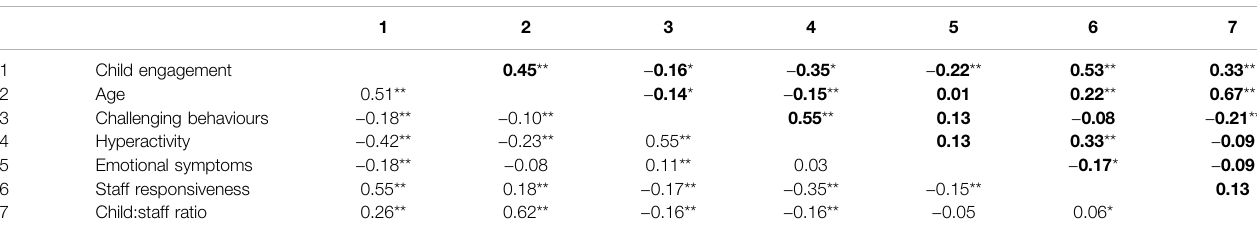
TABLE 3 | Correlations among variables (L2-learners in